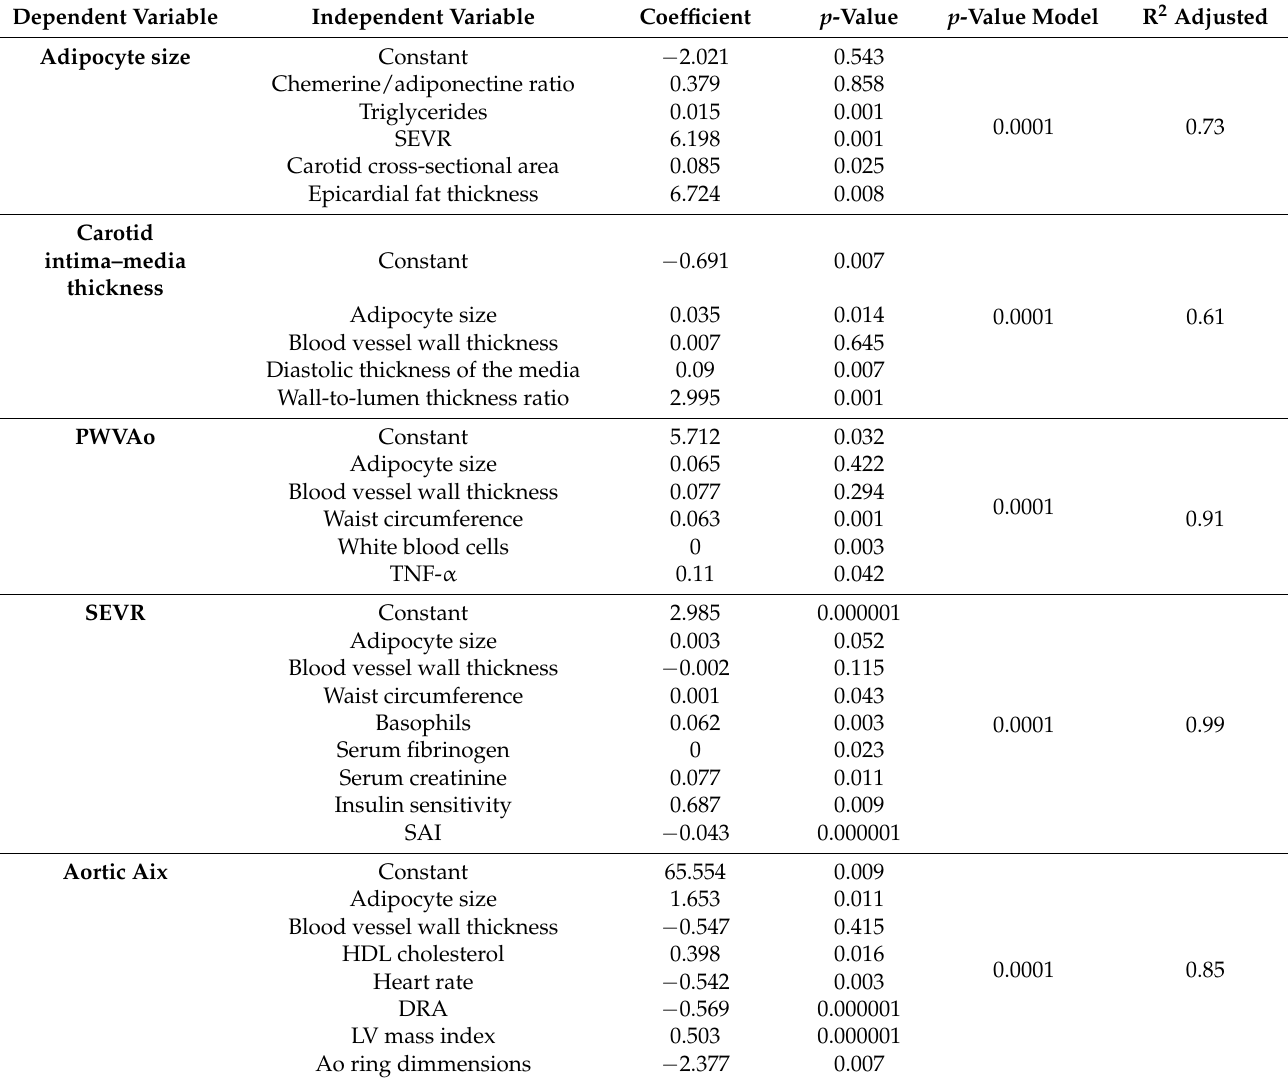
Table 4. Multiple linear regression models including parameters associated with arterial